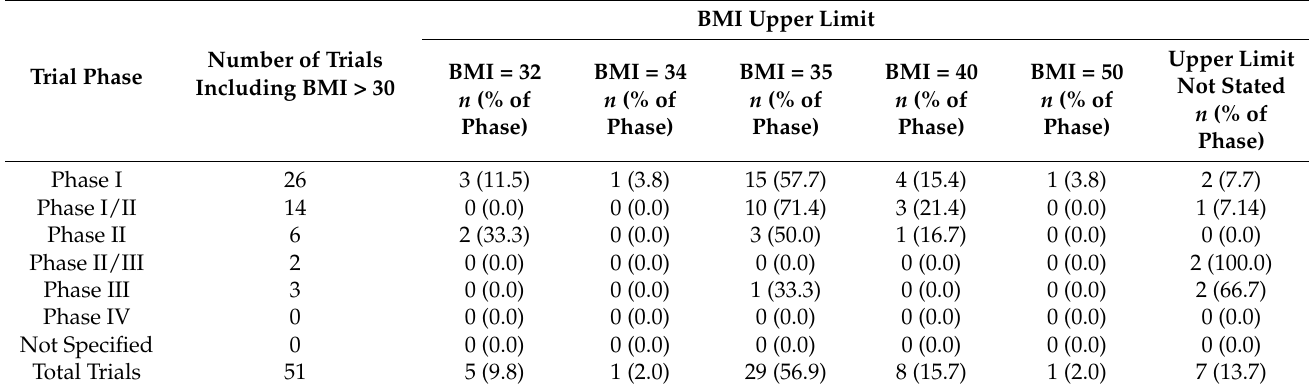
Table 4. BMI upper limits in trials with BMI > 30 by trial phase.